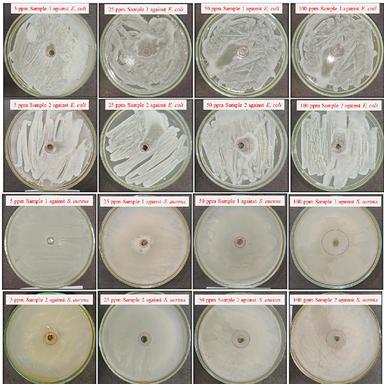
Antibacterial activity of ZnO NPs (two samples) against E. coli and S. aureus.